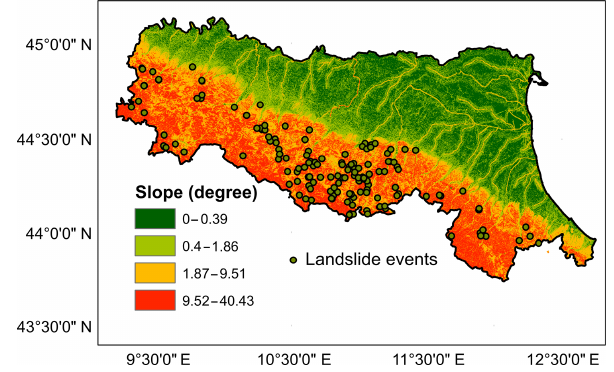
Figure 2. Landslide events with slope angle